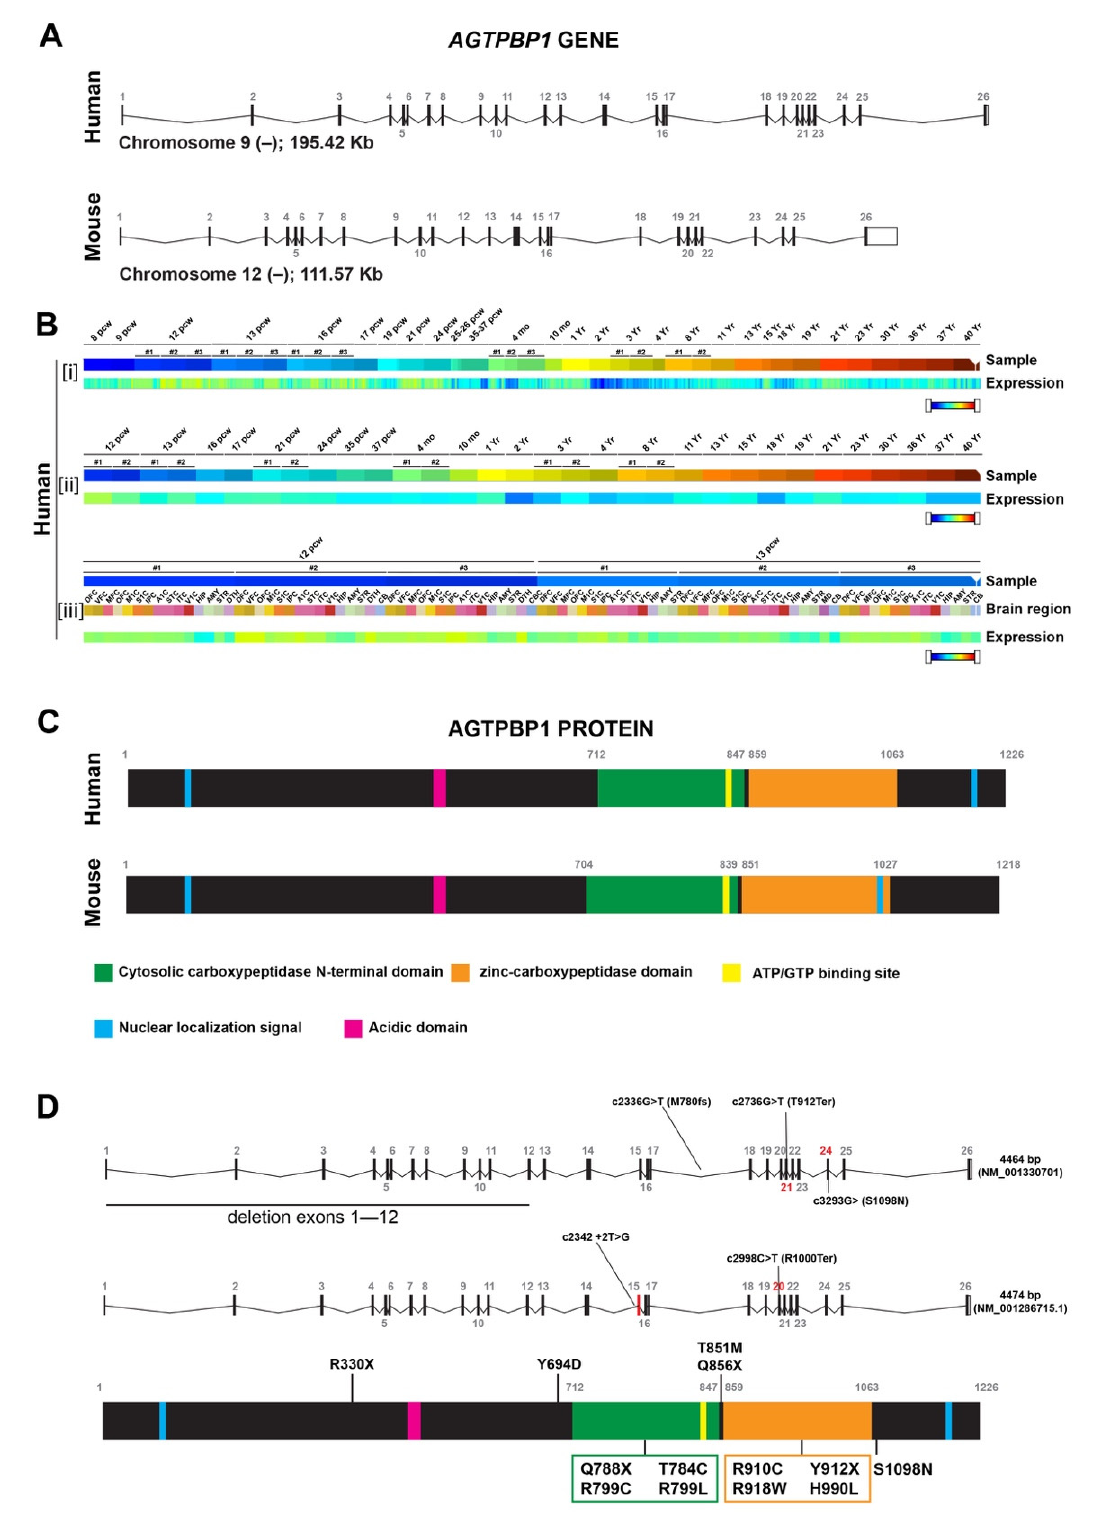
Figure 1. Genomic structure, organisation, expression and intron/exon distribution of AGTPBP1 in humans and in mice. ( A ) Genomic organisation of human AGTPBP1 and mouse AGTPBP1 loci. Figure assembled using current data from the Ensembl genome browser database (http://www.ensembl.org/index.html) (accessed on 10 July 2021). Chromosomal location, chromosome strand (+ or − ) used for transcription, and the size (Kb) of the genomic stretches containing the AGTPBP1 locus are also indicated for each species. Exons (solid vertical boxes) are numbered. The open box indicates the alternatively spliced region of the exon. ( B ) Schematic representation of [i] overall expression of the h AGTPBP1 gene throughout development in all studied brain structures, [ii] the specific expression of the h AGTPBP1 gene in the cerebellum throughout development, and [iii] region-specific